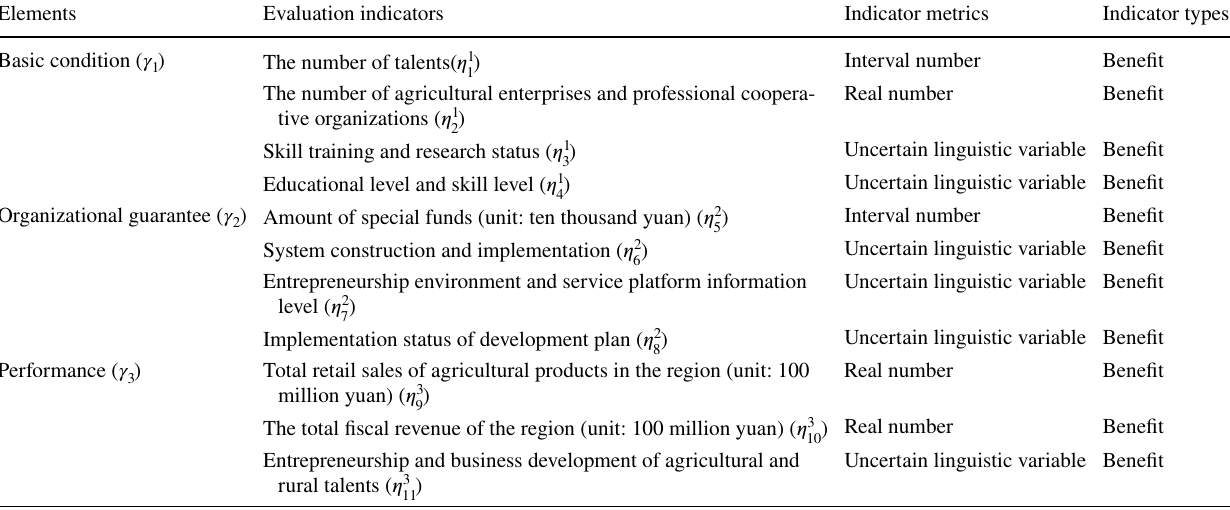
Table 2 Comprehensive evaluation indicator system of rural scientific practical talents in a region Elements